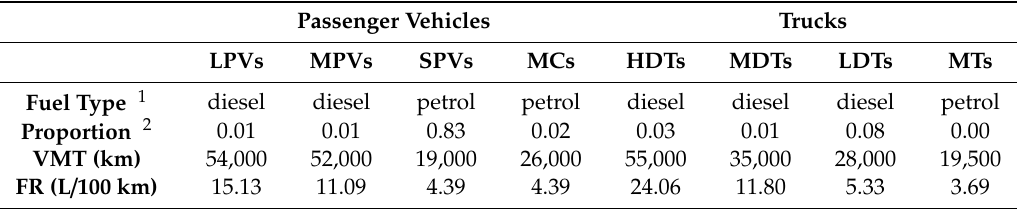
Table 2. Model parameters: Vehicle type, mileage, and fuel